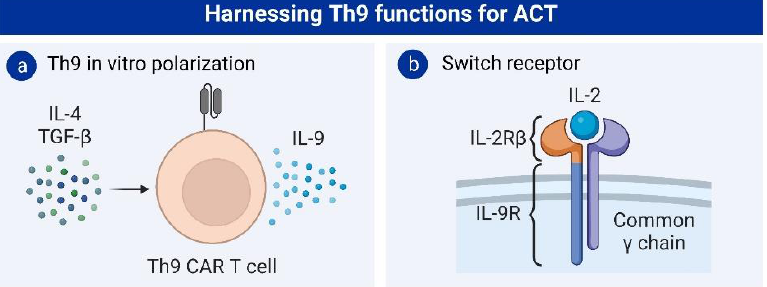
Figure 3. Strategies harnessing Th9 functions in ACT: ( a ) in vitro polarization of CAR T cells to IL-9-secreting T cells; and ( b ) chimeric receptor with the extracellular domain of the IL-2 receptor β (IL-2Rβ) and the IL-9R, which dimerizes with the common γ chain.